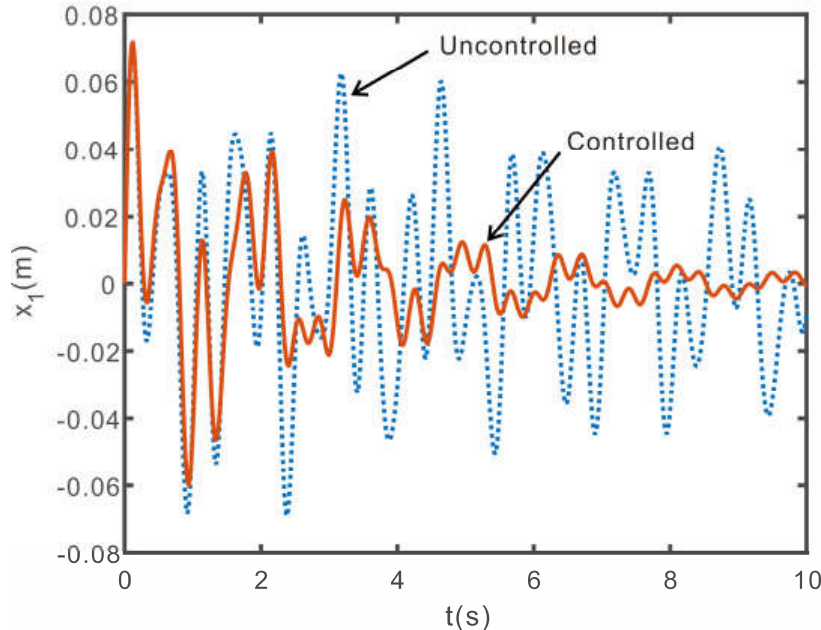
Figure 15. Impulse time-response of the closed-loop system.